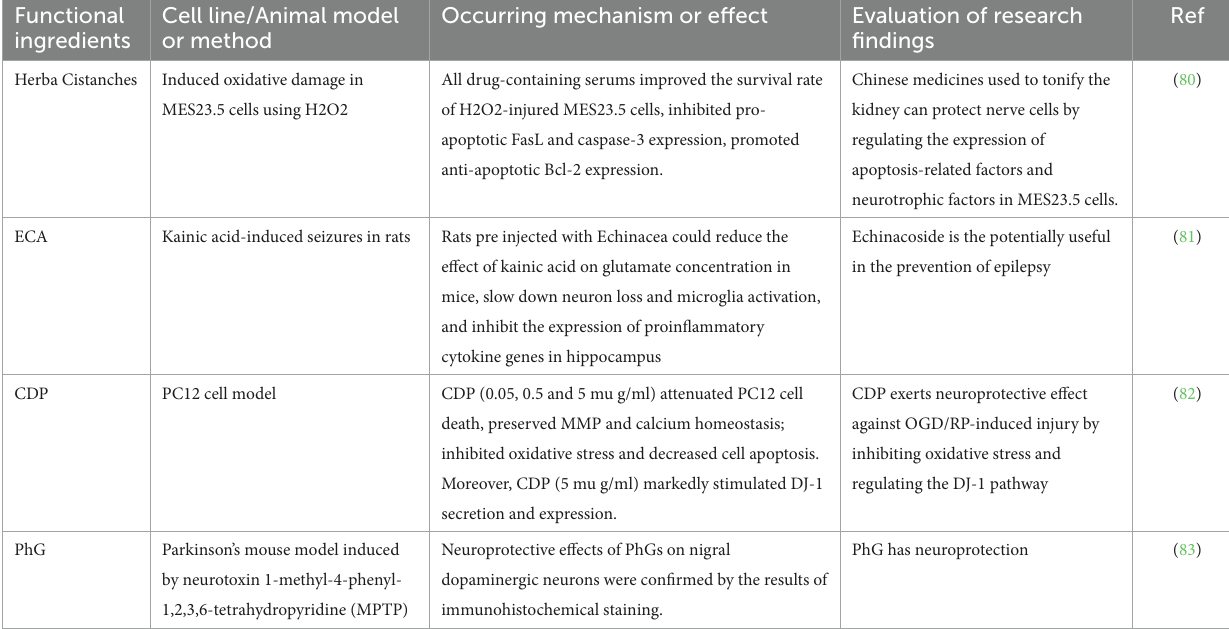
TABLE 8 Neuroprotective effect mechanism of cistanche. Functional